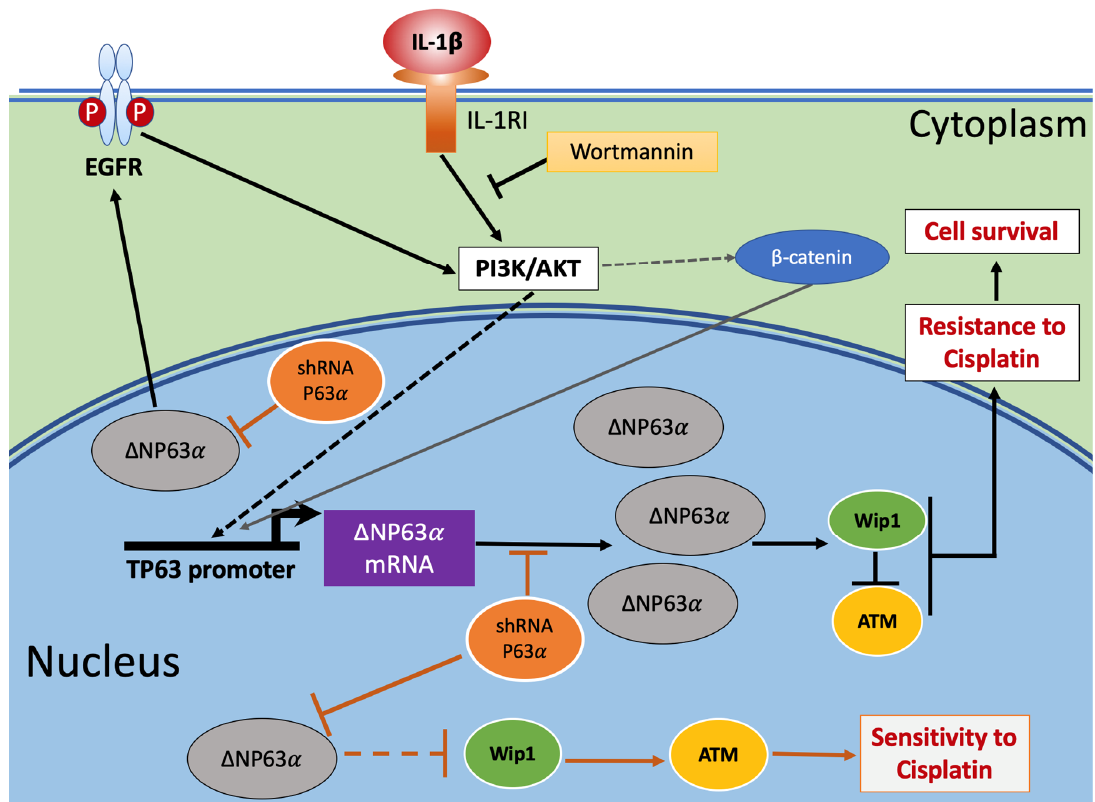
Figure 4. Graphical model of IL-1 β activation of signaling pathways leading to acquisition of resistance to cisplatin in breast cancer cells. Triggering of the IL-1 β /IL-1RI/ β -catenin pathway by IL-1 β induces the activity of downstream effectors phosphoinositide 3-kinase (PI3K)/protein kinase B (AKT) [4], leading to translocation of β -catenin to the nucleus and regulation of proteins that participate in the acquisition of resistance to cisplatin. The induced upregulation of ∆ Np63 α regulates the expression of cell survival (pEFGR) and DNA damage response (Wip1 and ATM) proteins. At the same time, the increased levels of ∆ NP63 α activate EGFR, which, through a feed-back loop, maintains PI3K/AKT activity and the continuity of the downstream signaling initiated by IL-1 β , which leads to resistance to cisplatin. However, if ∆ NP63 α overexpression is hampered by silencing its mRNA (shRNAP63 α ), the lower levels of ∆ NP63 α expressed in the cells will not be sufficient to maintain high levels of Wip1, thereby increasing ATM levels and the sensitivity to cisplatin. Dashed arrows indicate indirect positive modulation in the pathway that was previously reported [4,14]. The link between low levels of ∆ Np63 α and Wip1 is represented in the figure with a dashed line because the step(s) leading to decreased levels of Wip1 are not yet well